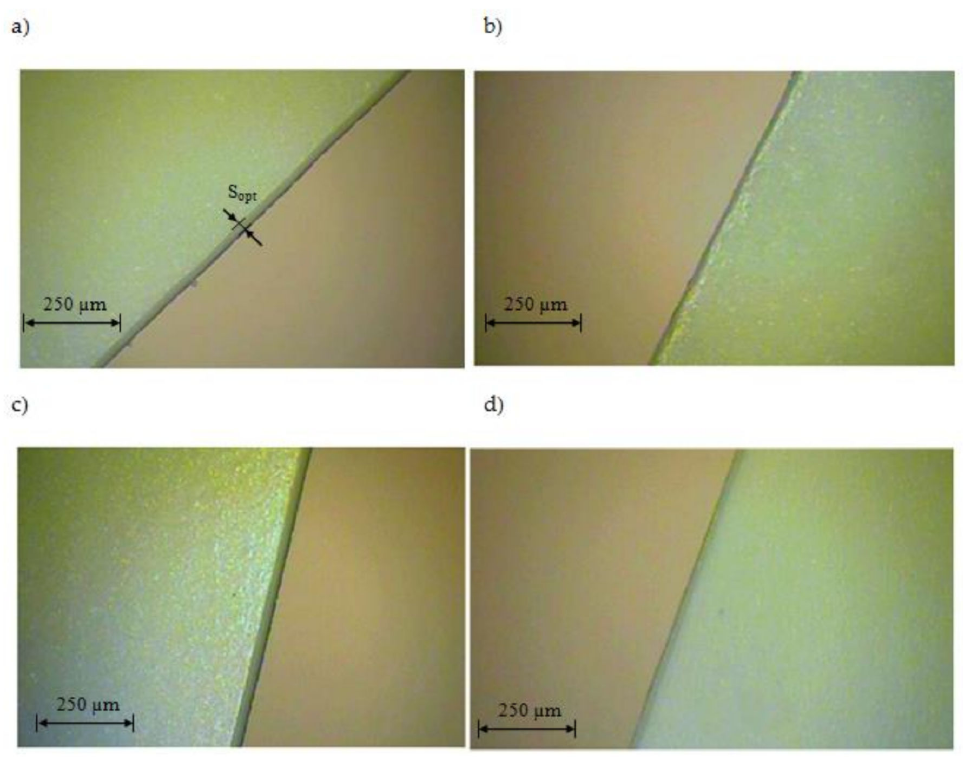
Figure 16. View of the cut surface of foil with thickness: ( a ) t = 50 µ m ( v = 1.29 m / s, f = 110.1 kHz), ( b ) t = 60 µ m ( v = 0.867 m / s, f = 47.9 kHz), ( c ) t = 70 µ m ( v = 1.499 m / s, f = 112.1 kHz), ( d ) t = 80 µ m ( v = 1.5 m / s, f = 84.8 kHz).